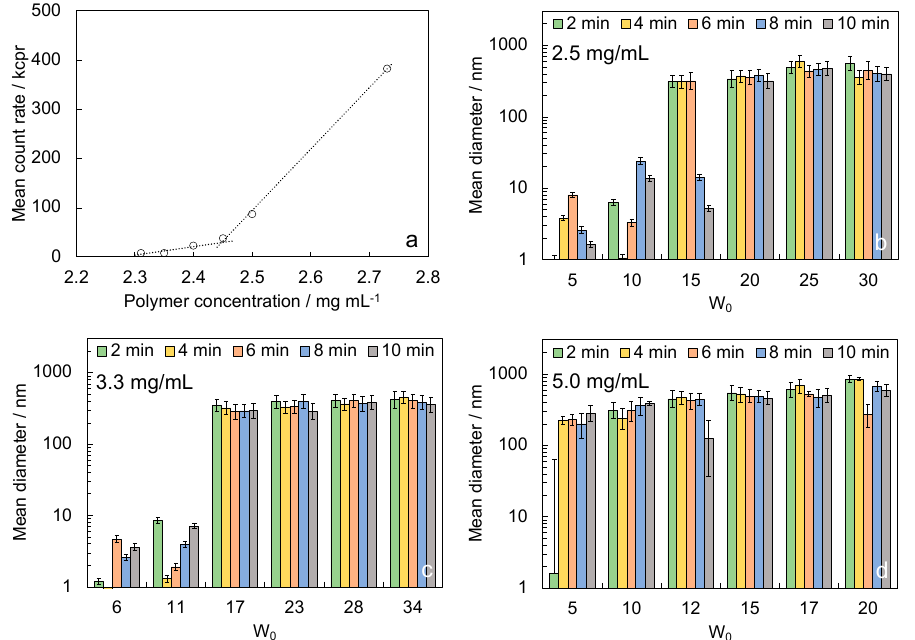
Figure 3. Optimization of the reversed micelles recipe: ( a ) calculation of the critical micellar concentration from DLS analysis—the plot reports one of the three performed experiments as an example; reversed micelle size, measured by DLS, at 2, 4, 6, 8, and 10 min after the addition of water to the polymer solution with concentrations ( b ) 2.5, ( c ) 3.3, and ( d ) 5.0 mg/mL.